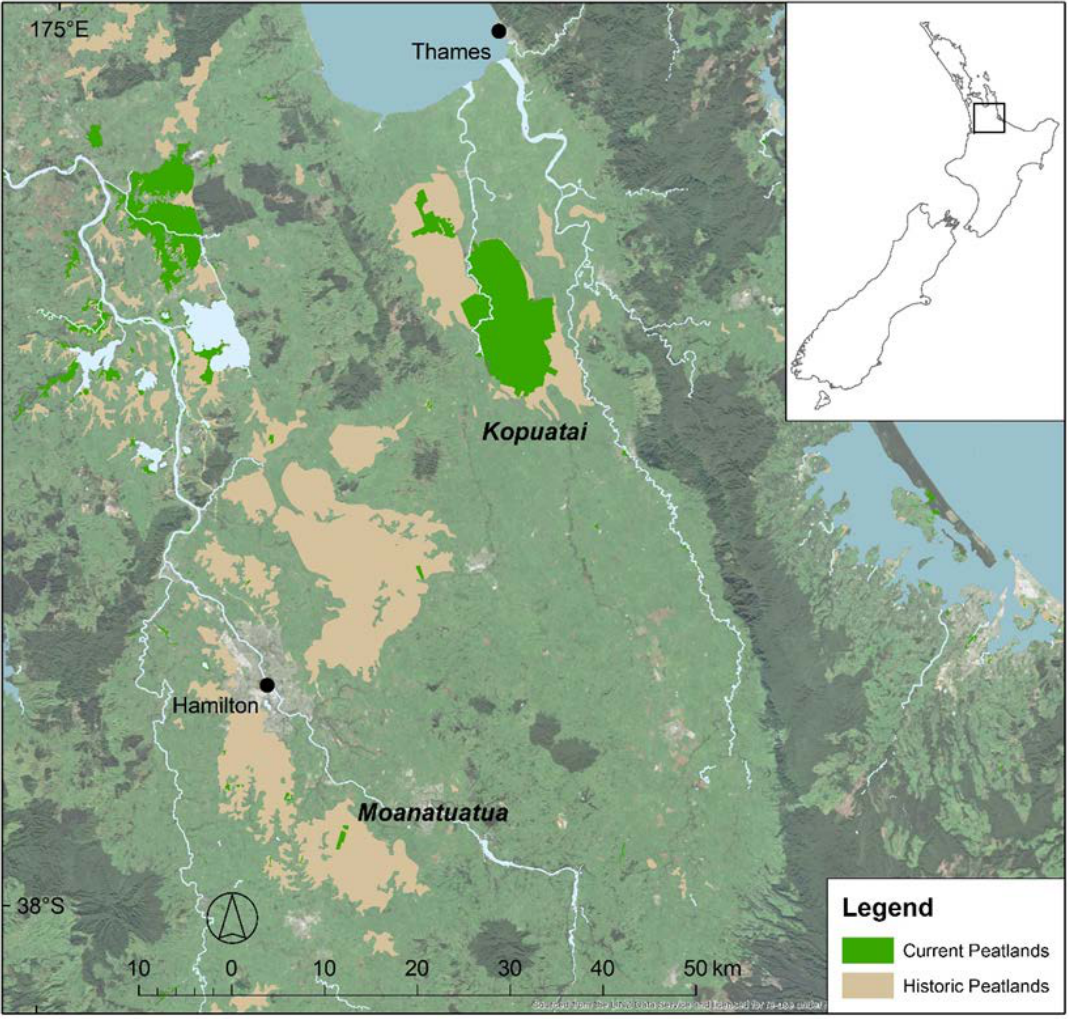
Figure 1. Location of modified bog, Moanatuatua, and relatively intact bog, Kopuatai, in the Waikato region, North Island, New Zealand. A separate bog remnant lies north-west of Kopuatai. Grey indicates